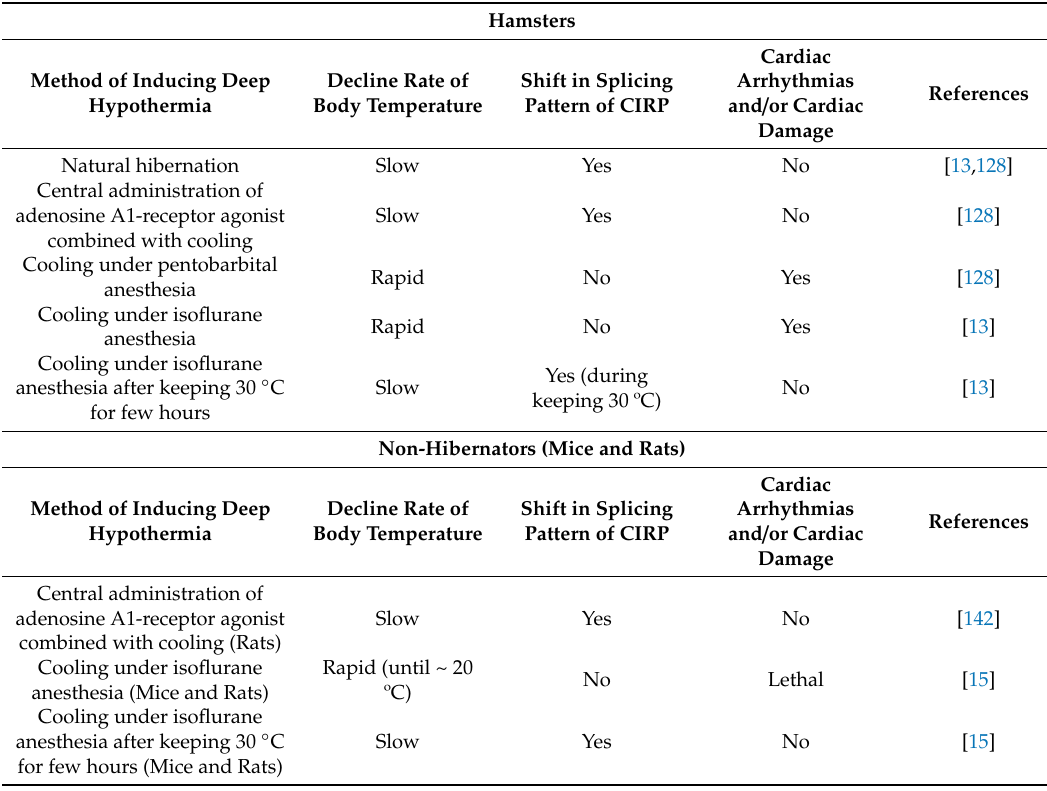
Table 2. Decline rate of body temperature, shift in splicing pattern of CIRP and cardiac state in hamsters and non-hibernators under deep